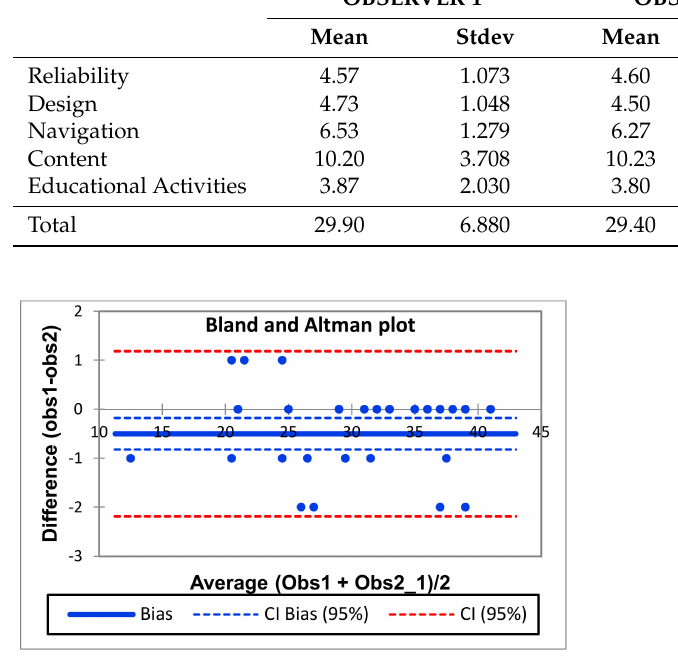
Figure 3. Bland-Altman